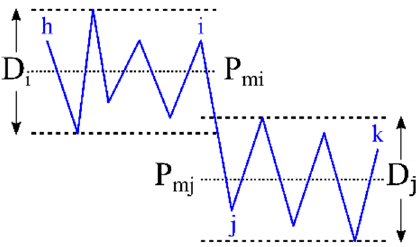
Figure 2. Estimating CVR by the direct method.